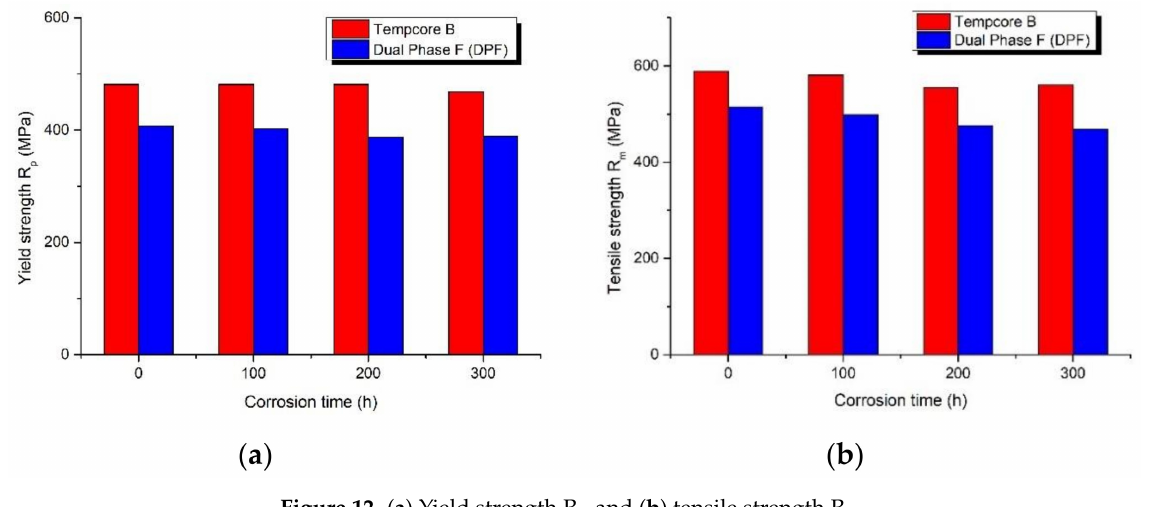
Figure 12. ( a ) Yield strength R p and ( b ) tensile strength R m .